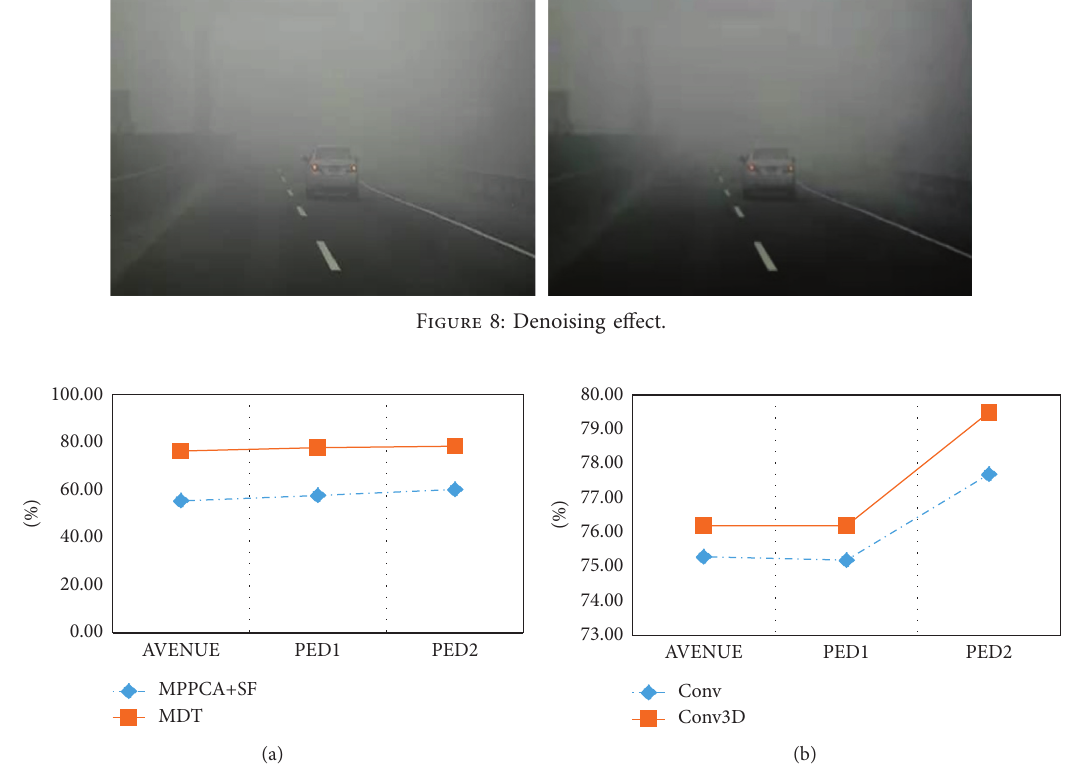
Figure 9: Comparison of experimental results of different methods. (a) Comparison of experimental results of MPPCA +SF and MDT. (b) Comparison of experimental results of Conv and Conv3D.